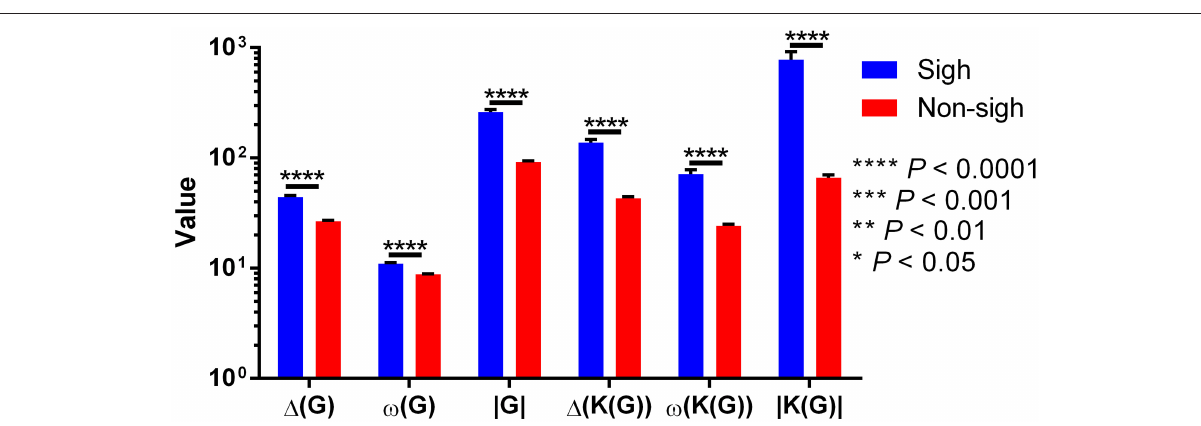
FIGURE 10 | Visibility ( 1 ( G ), ω ( G ), and | G | ) and maxclique ( 1 ( K ( G )), ω ( K ( G )), and | K ( G ) | ) graph parameters of sigh and non-sigh waveforms. Data is showed as mean ± S.E.M. Significant differences between non-sigh and sigh were determined using a two-way ANOVA, followed by Bonferroni’s multiple comparisons. ∗ P < 0.05, ∗∗ P < 0.01, ∗∗∗ P < 0.001, ∗∗∗∗ P < 0.0001. Sighs, n = 20; non-sighs, n =